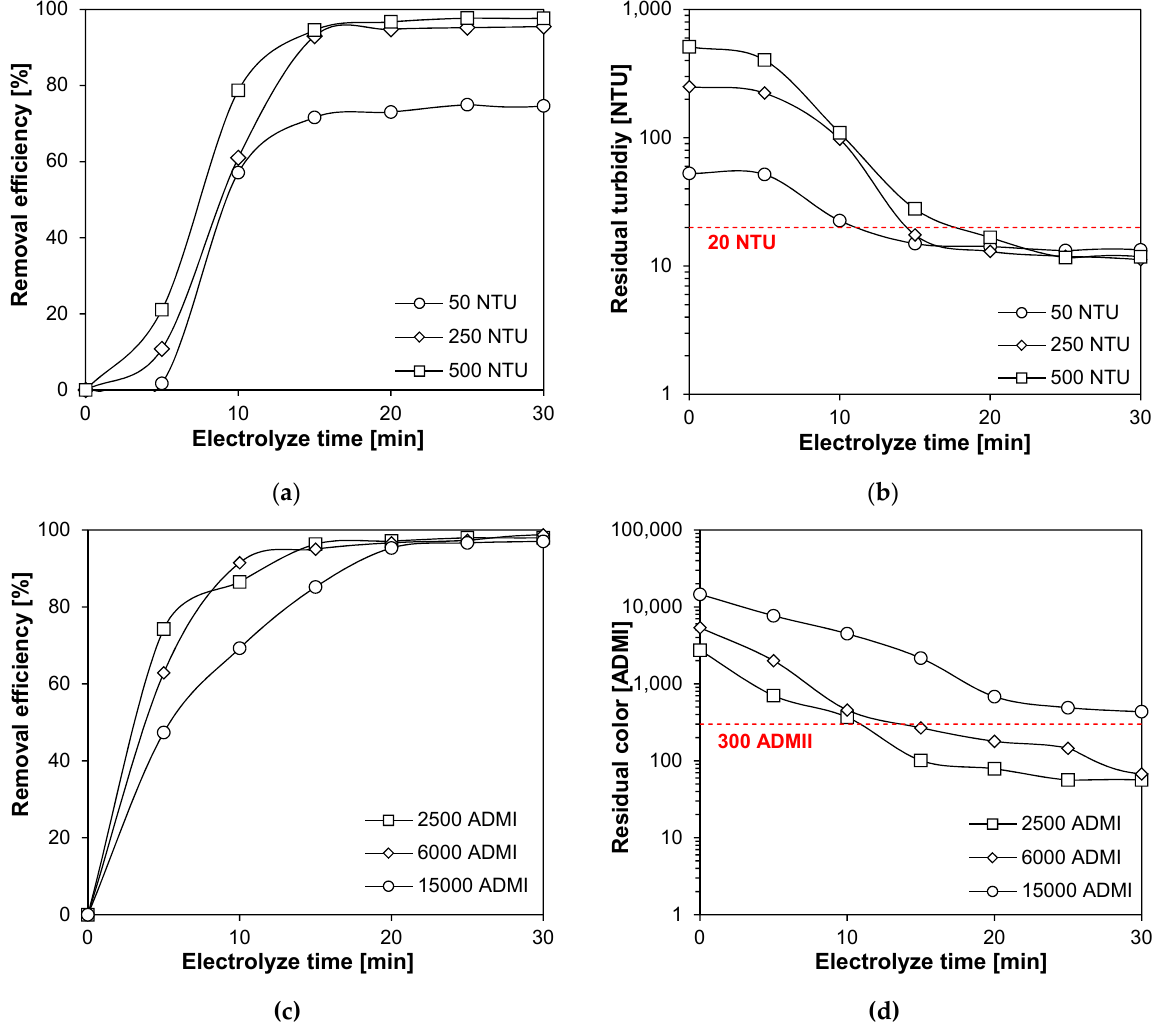
Figure 5. Kinetic removal at different initial concentrations: ( a ) turbidity removal efficiency, ( b ) residual turbidity, ( c ) color removal efficiency, and ( d ) residual color (current density 4.5 mA/cm 2 ). For color, it required more electrolyze and treatment time for the molecule or colloid